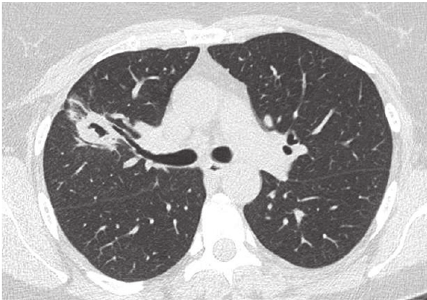
Figure 3: CTthorax (lung window) axial view showing the cavitary lesion in the right upper lobe of the